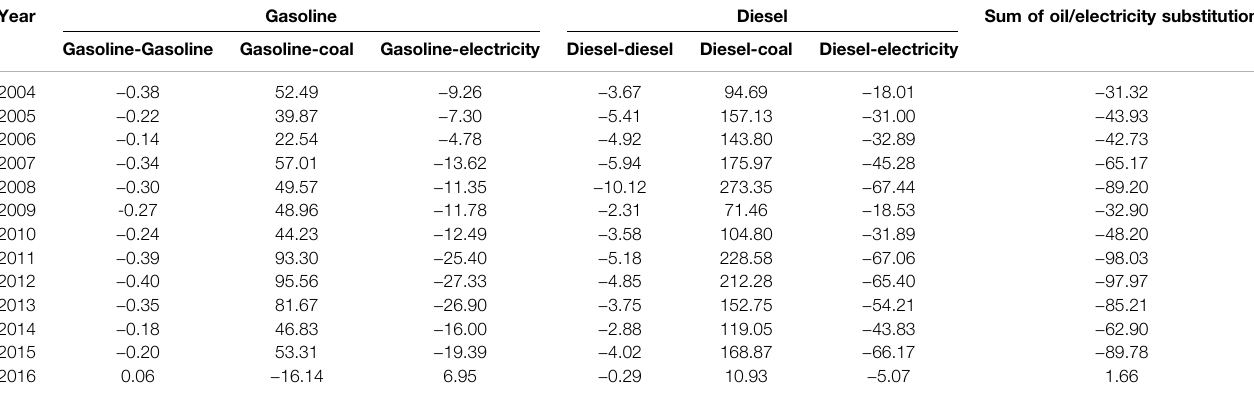
TABLE 6 | Carbon mitigation potential by removing oil price distortions (million tons of CO 2